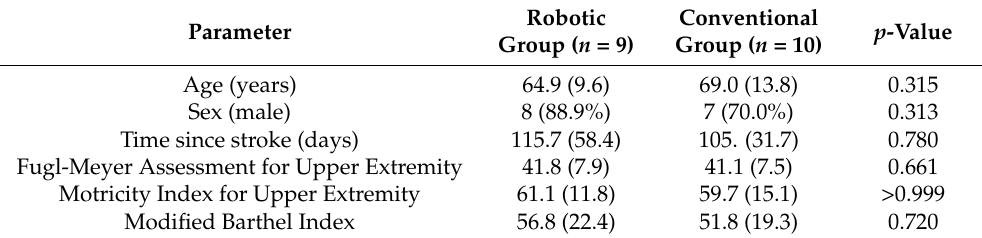
Table 2. Demographic and clinical features of the sample. Data are reported as mean (SD), or n (%), as appropriate. p -values refer to the Mann–Whitney U test or Fisher’s exact test, as appropriate.